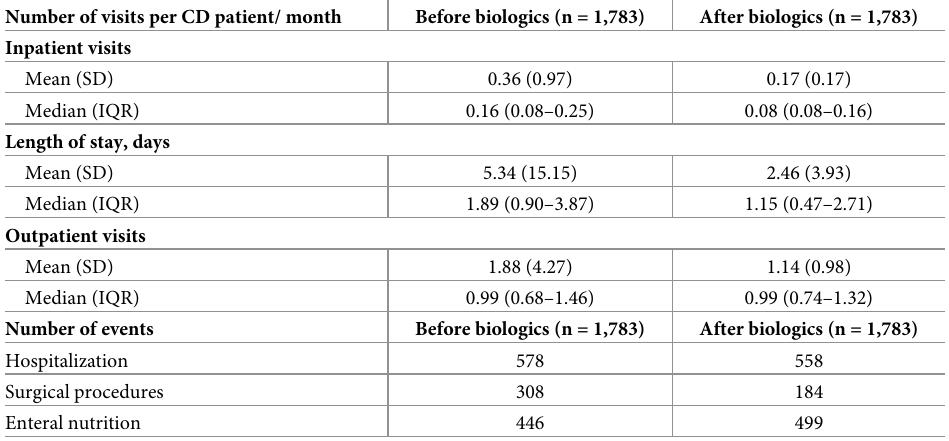
Table 2. CD-related HRU one year before and one year after biologic index date.